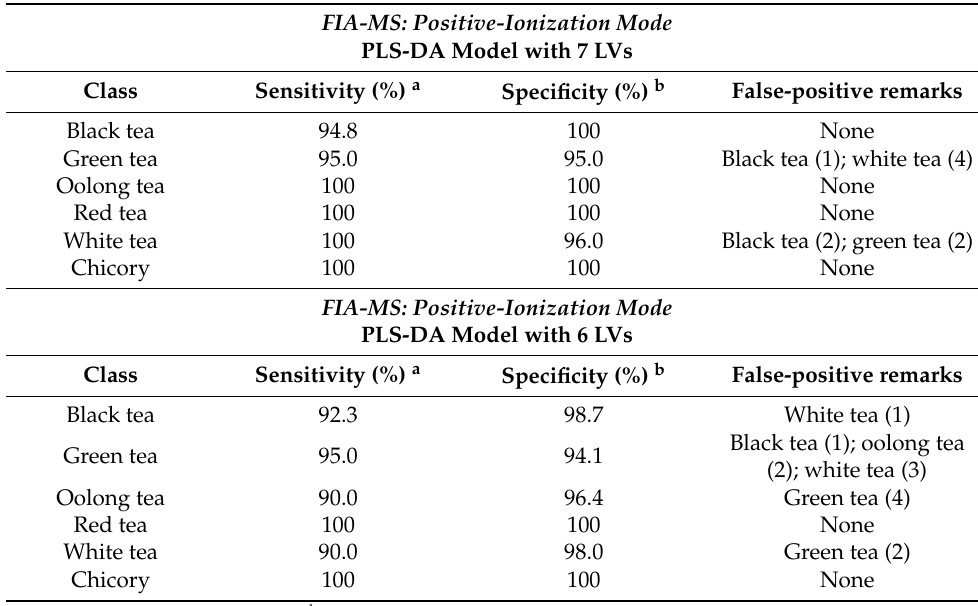
Table 3. PLS-DA cross-validated results for multiclass models from both positive- and negative- ionization data